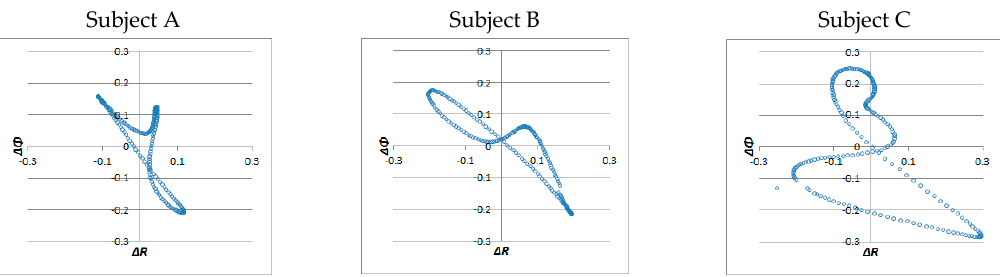
Figure 2. Pattern formations of ankle EP trajectory in running